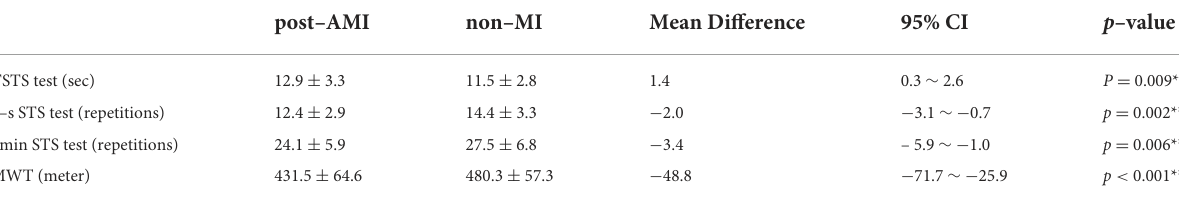
TABLE 5 Comparison of STS tests and 6MWT performance between post–AMI and non–MI